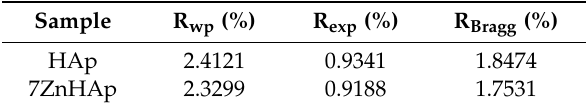
Table 1. Values obtained for R final factors (R wp , R exp ¸si R Bragg ).